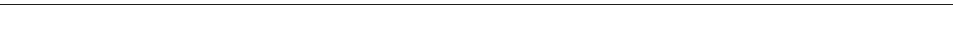
Fig. 2 Jag1 de fi ciency results in reduced levels of ISC markers in the tumor cells. a qRT-PCR to measure the mRNA levels of selected ISC markers in wild- type and Jag1-de fi cient adenomas. The average and standard deviation (s.d.) of fi ve tumors analyzed is represented. b In situ hybridization to determine the expression pattern of c-Myc and different stem cell markers in tumor sections from the indicated genotypes. c Quanti fi cation of the percentage of tumors containing detectable levels of the indicated genes as determined by ISH. A minimum of 20 tumors of each genotype was included in the analysis. d IF analysis of LGR5 protein in normal or adenoma tissue in the indicated genotypes and quanti fi cation of 15 randomly selected areas (right panels). e IHC analysis of the Paneth cell marker lysozyme and the absorptive marker carbonic anhydrase II (CAII) in tumors from the indicated genotypes. Graphs represent the number of tumors expressing these markers in the indicated genotypes. Unpaired t -test, two-tailed, was used to determine the statistical signi fi cance of the differences (*** p < 0.001). Scale bars represent 75 μ